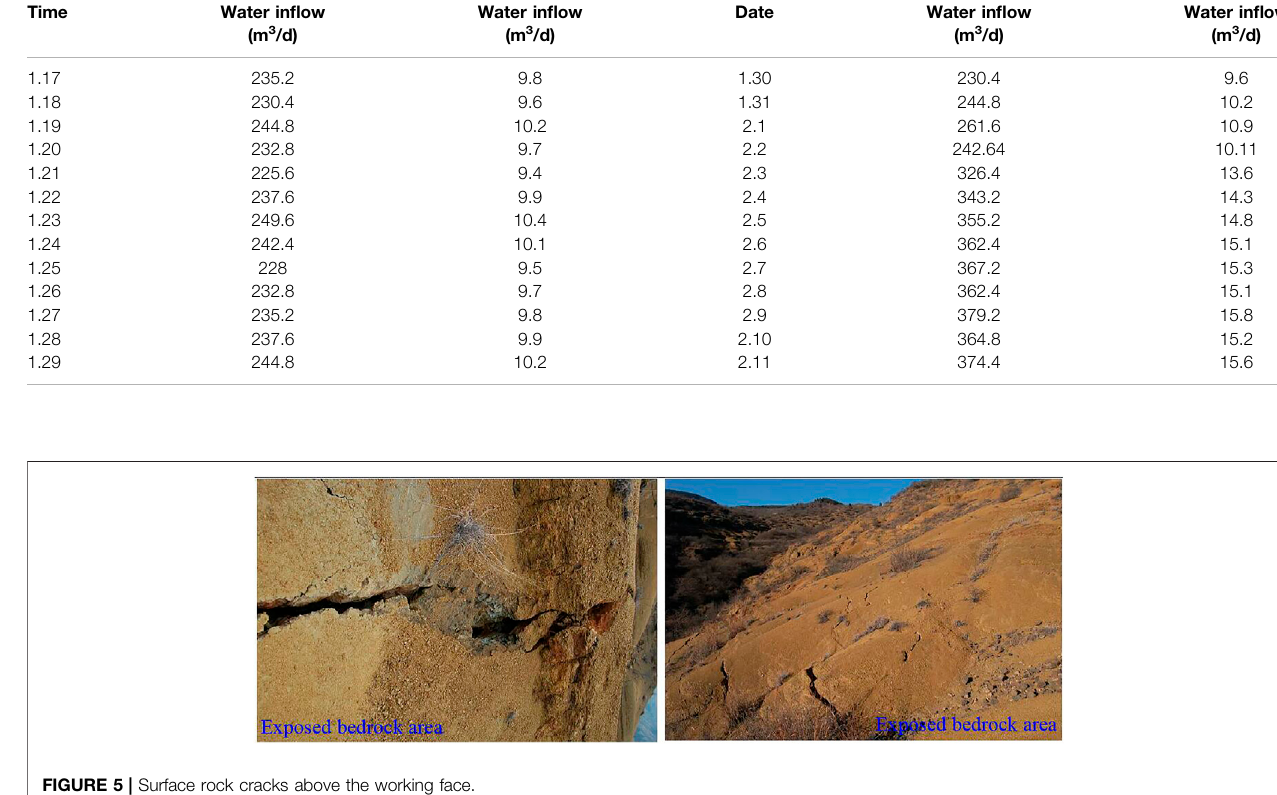
TABLE 3 | Water in fl ow of the fully mechanized caving face P2. Time Water in fl ow (m 3 /d)